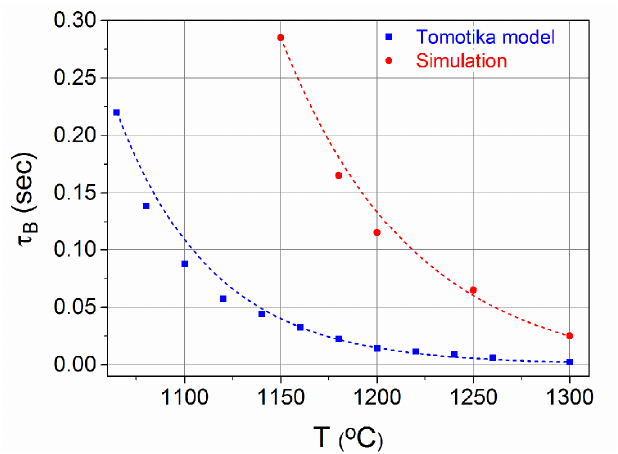
Figure 5. Breakup time as a function of temperature calculated using simulations (red) and the Tomotika model (blue).